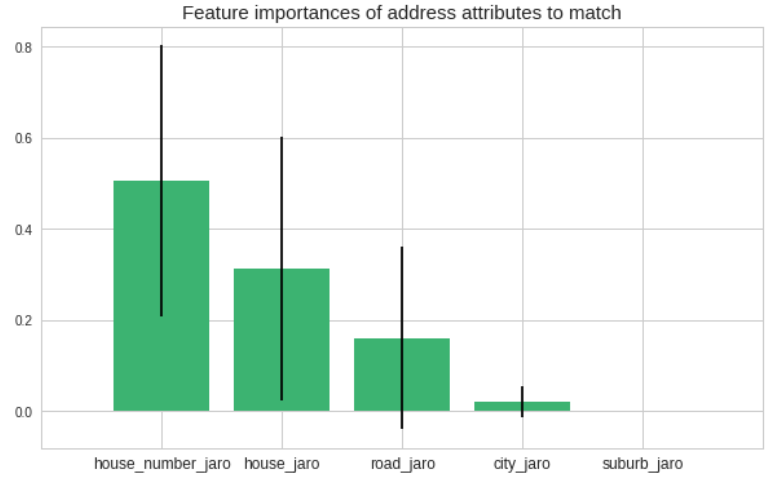
Figure 3: Output generated by code